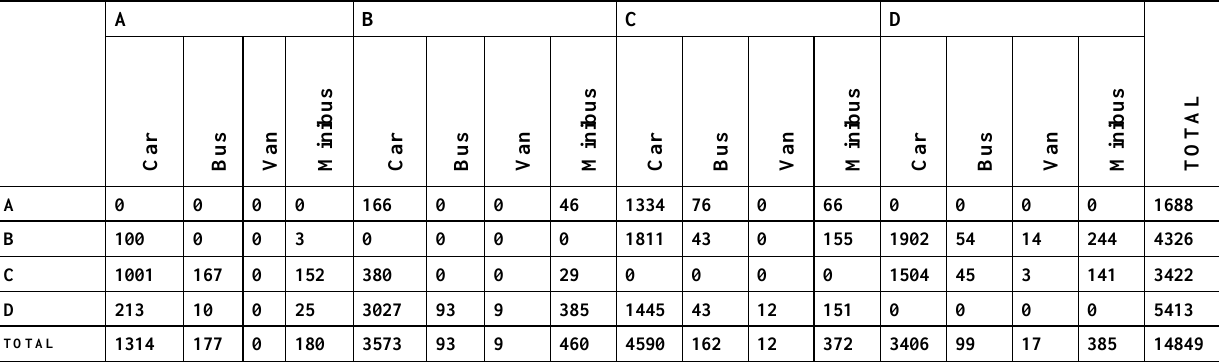
Table 3. Traffic volume counts in the evening of K1 junction (16: 00-18: